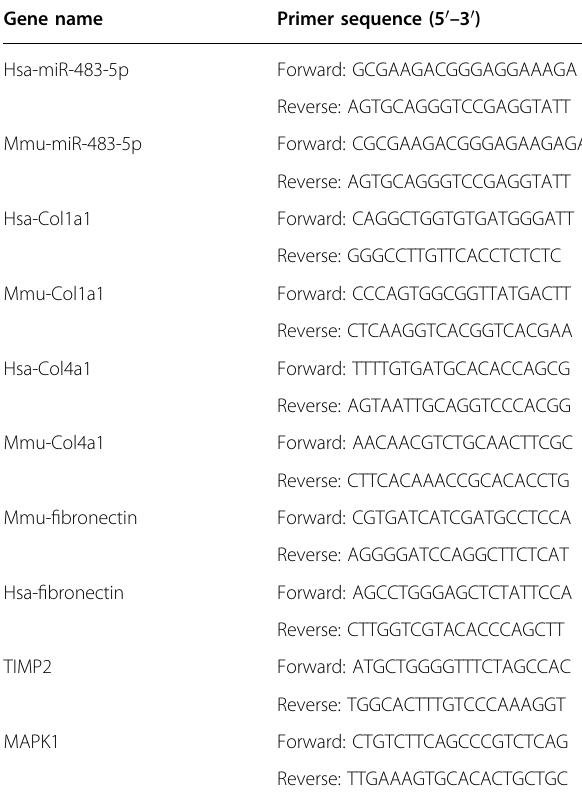
Table 1 The sequences of all primers used in